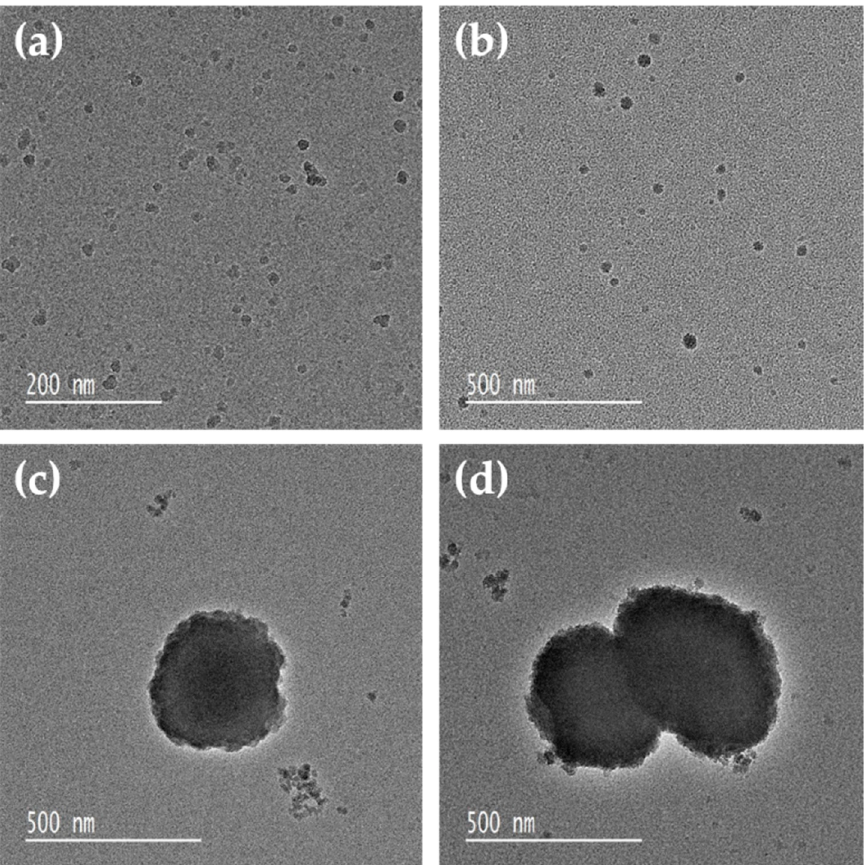
Figure 4. TEM images of silicon oxide particles captured on the pure carbon membrane for 10 s after delay times of ( a ) 0 min, ( b ) 2 min, ( c ) 7 min, and ( d ) 30 min using the quartz tube with the conical nozzle.